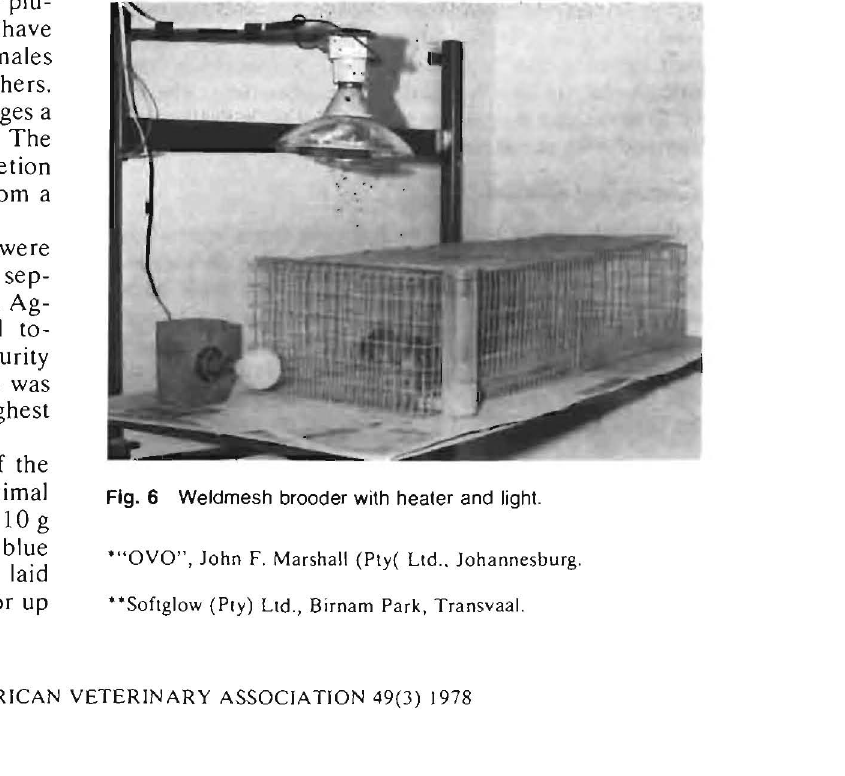
Fig. 5 Quail eggs being incubated in cardboard rings. Batches of eggs were incubated in a small still air chicken egg incubator* at 38°C (Fig. 5). Batches of eggs were separated using cardboard rings and the eggs were turned by hand twice daily. A relative humidity of 60- 65% was maintained in the incubator until hatching. the eggs with water as the chicks pipped. Quail eggs hatched in 17,5 days and chicks were left in the incuba